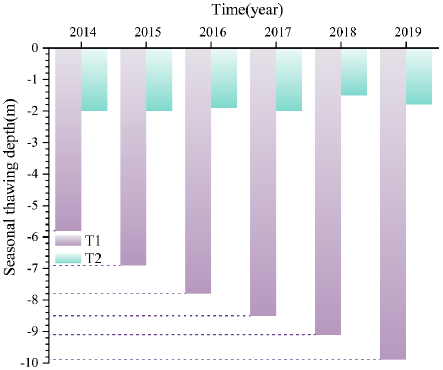
Figure 4. The seasonal thawing depth of holes T1 and T2 versus time.